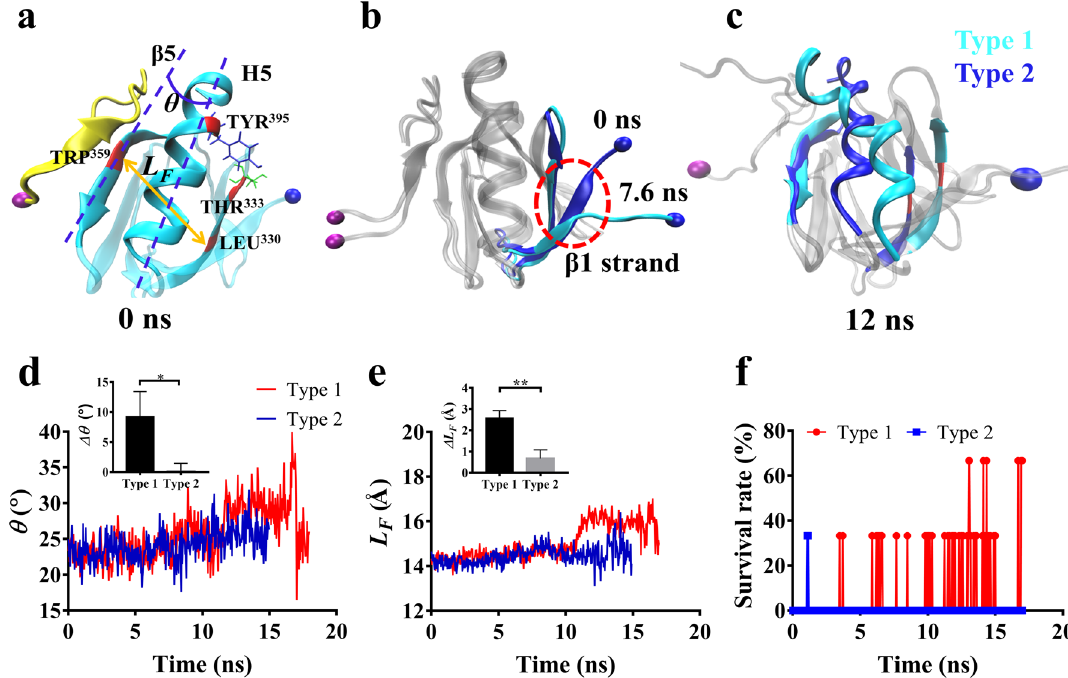
Figure 4. Pull-induced allostery of the complex. ( a – c ) The snapshots of the pulled complex of β3 integrin (yellow) with Talin F3 domain (cyan) along the dissociation pathway in type 1 at different pull time. The purple sphere was the fixed atom, and the blue sphere denoted the steered atom. ( a ) Schematic diagrams for the angle θ between H5 helix and β5 strand of F3 domain (blue dotted line), the distance L F (cyan) between two Cα-atoms of LEU 330 on β2-strand and TRP 359 on β5-strand of F3 (orange line) and the newly formed H-bond between TYR 395 on H5 helix and THR 333 on β2-strand of F3 domain. ( b ) The β1 strand of the ligated F3 domain (cyan) became unfolded or spread at pull time of 7.6 ns or pull force of 150pN in comparison with its static state (blue) (pull time = 0 ns), and ( c ) the hydrophobic pocket of the ligated F3 domain became open at pull time of 12 ns. The time course of the angle θ ( d ) and the distance L F ( e ) and their differences between start point and rupture point Δθ and ΔL F in type 1 and 2 run modes, respectively. ( f ) The mean survival rate for the newly formed H-bond between TYR 395 on H5 helix and THR 333 on β2-strand of F3 domain in type 1 and 2 run modes, all data from three